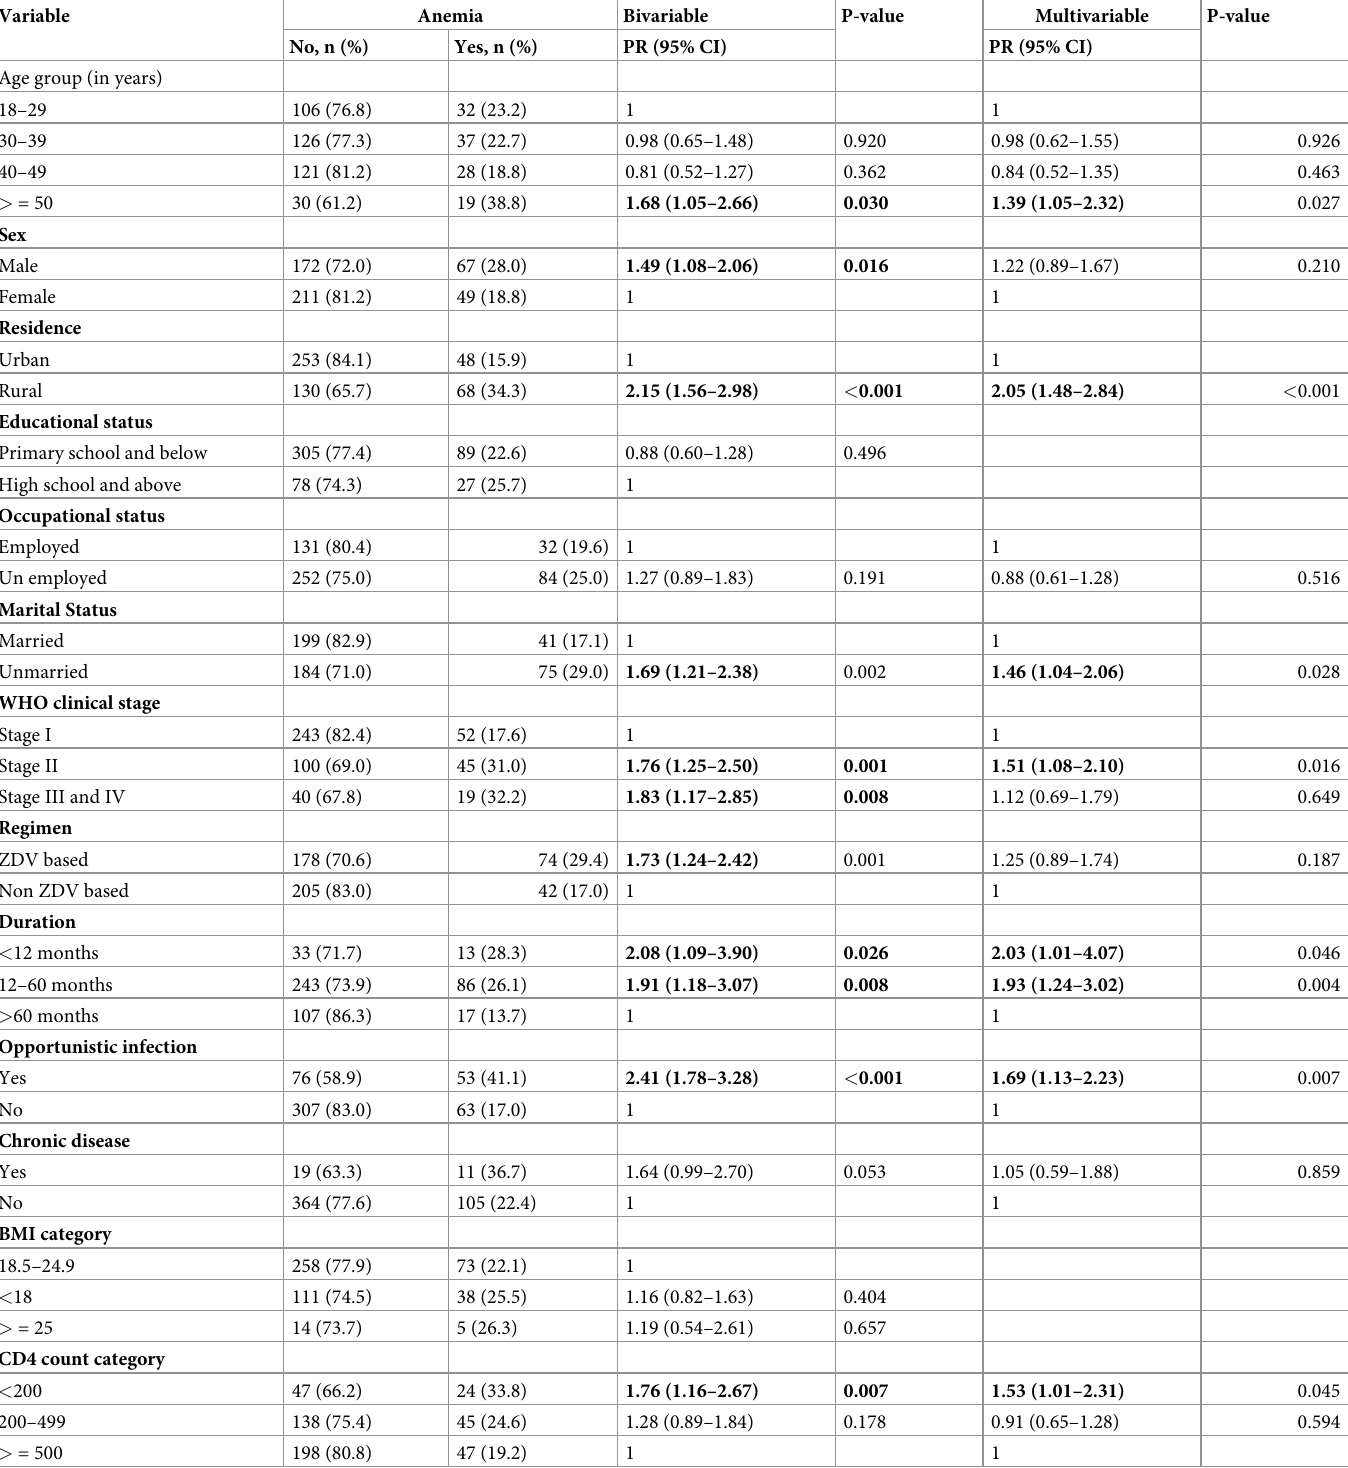
Table 5. Factors associated with anemia among HIV infected patients on HAART at Mahal-Meda Hospitals, Northern Shewa Zone, Ethiopia, 2018 (n = 499).